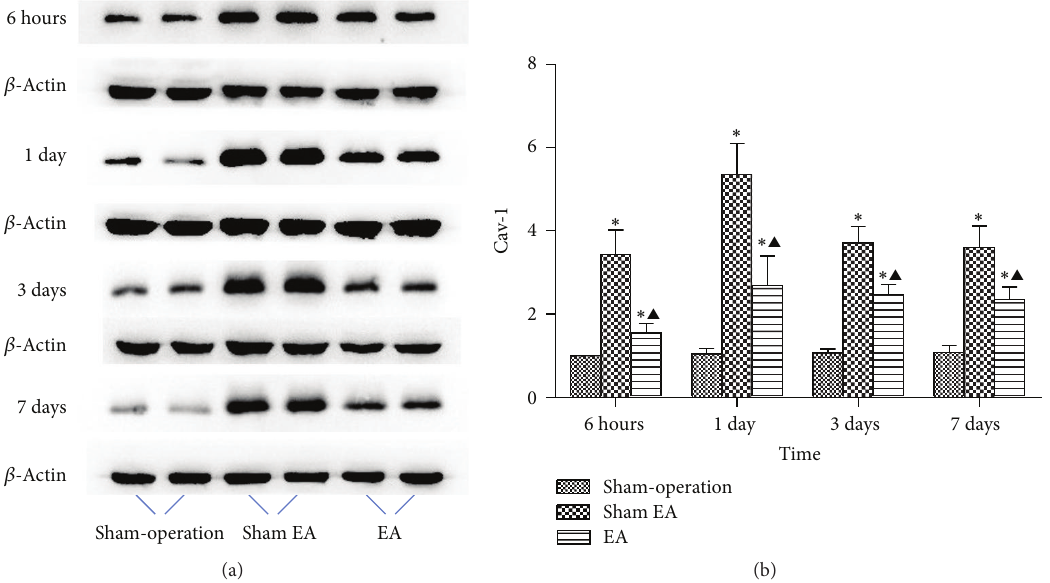
Figure 4: Western blot analysis on the overall expressions of Cav-1 in brain from rats (mean ± SD, 𝑛 = 6 ). (a) Expression of Cav-1 in brain. (b) Representative statistic results. One-way analysis of variance (ANOVA) was used for multiple group experiments comparisons and followed by Dunnett test for comparison of two groups within the multiple groups. ∗ 𝑃 < 0.05 , compared with Sham-operated group. 󳵳 𝑃 < 0.05 compared with Sham EA group.